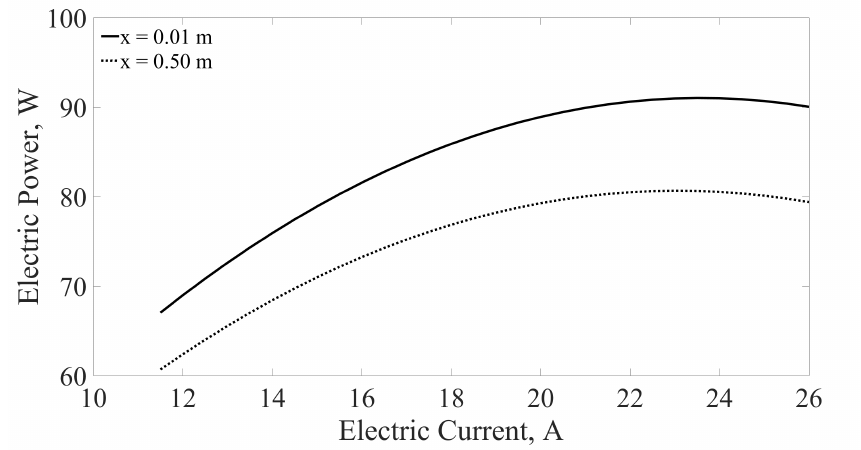
Figure 10. Example on the dependency of a TEG power output on its operation current at two points along the combustion